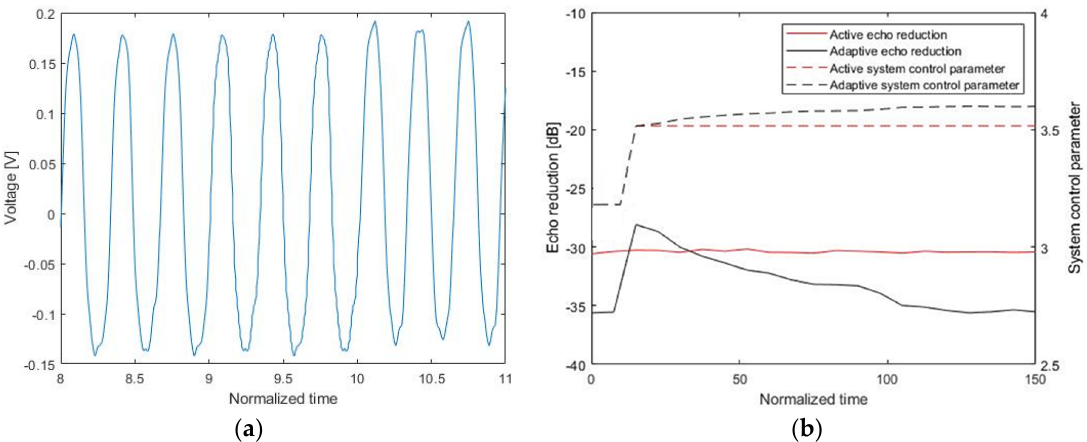
10 of 12 adaptive control schemes. When active control was used, (cid:1833) (cid:2868) was fixed, and echo reduction was about −31.1 dB. In the adaptive control approach, the control signal (cid:1848) (cid:3030) varied with the updated real- time control parameter according to Equations (13) and (14). The final echo reduction improved from −31.1 dB to −36.5 dB over time. Thus, the use of the adaptive parameter ( (cid:2009) ) updated in real time showed better reduction performance in the multilayer piezoelectric sensor. ( a ) ( b ) Figure 15. Use of active noise control: ( a ) a continuous input signal and ( b ) the echo reduction rate and system control parameter. The echo reduction experiment was conducted by changing the frequency of the source signal at 10 s. Figure 16 shows an input signal on the project and the output of the hydrophone, respectively. The echo reduction is compared between the active control and the adaptive control schemes. The echo reduction achieved by the active control scheme is about −31.1 dB. With the adaptive control